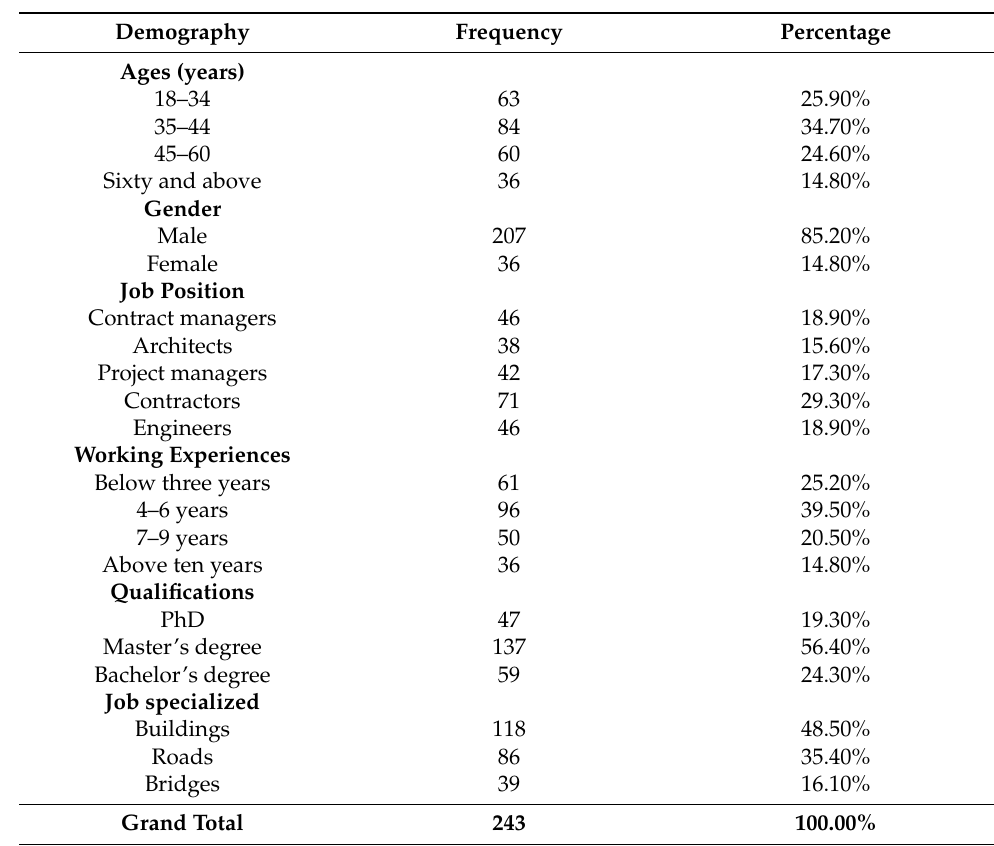
Table 1. Profile of